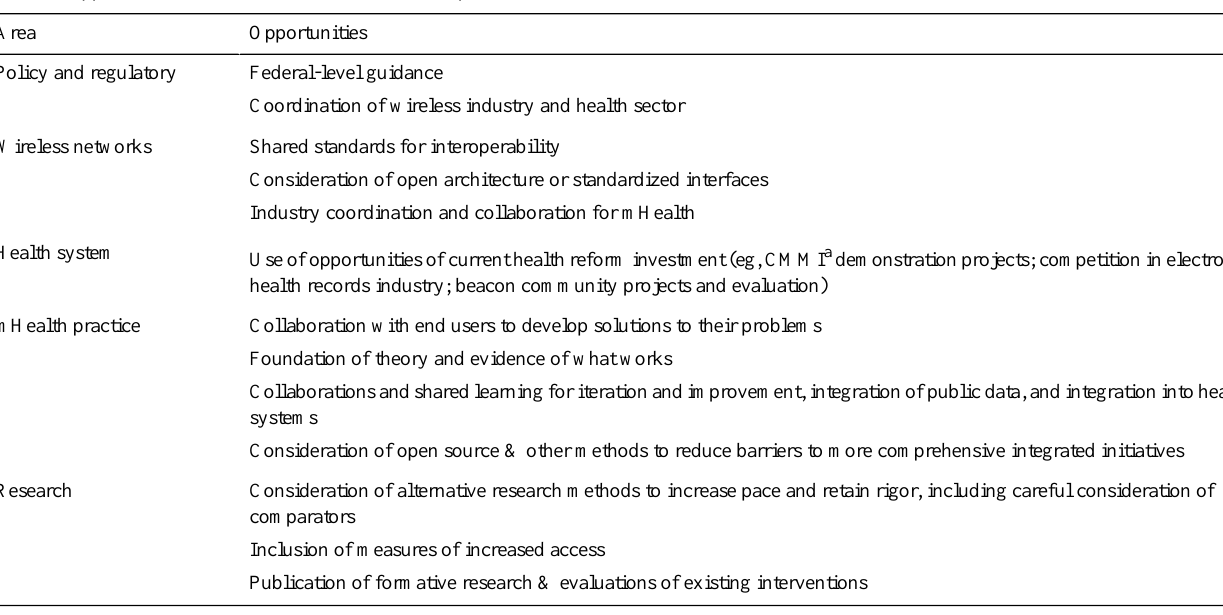
Table 2. Opportunities to address issues in mHealth